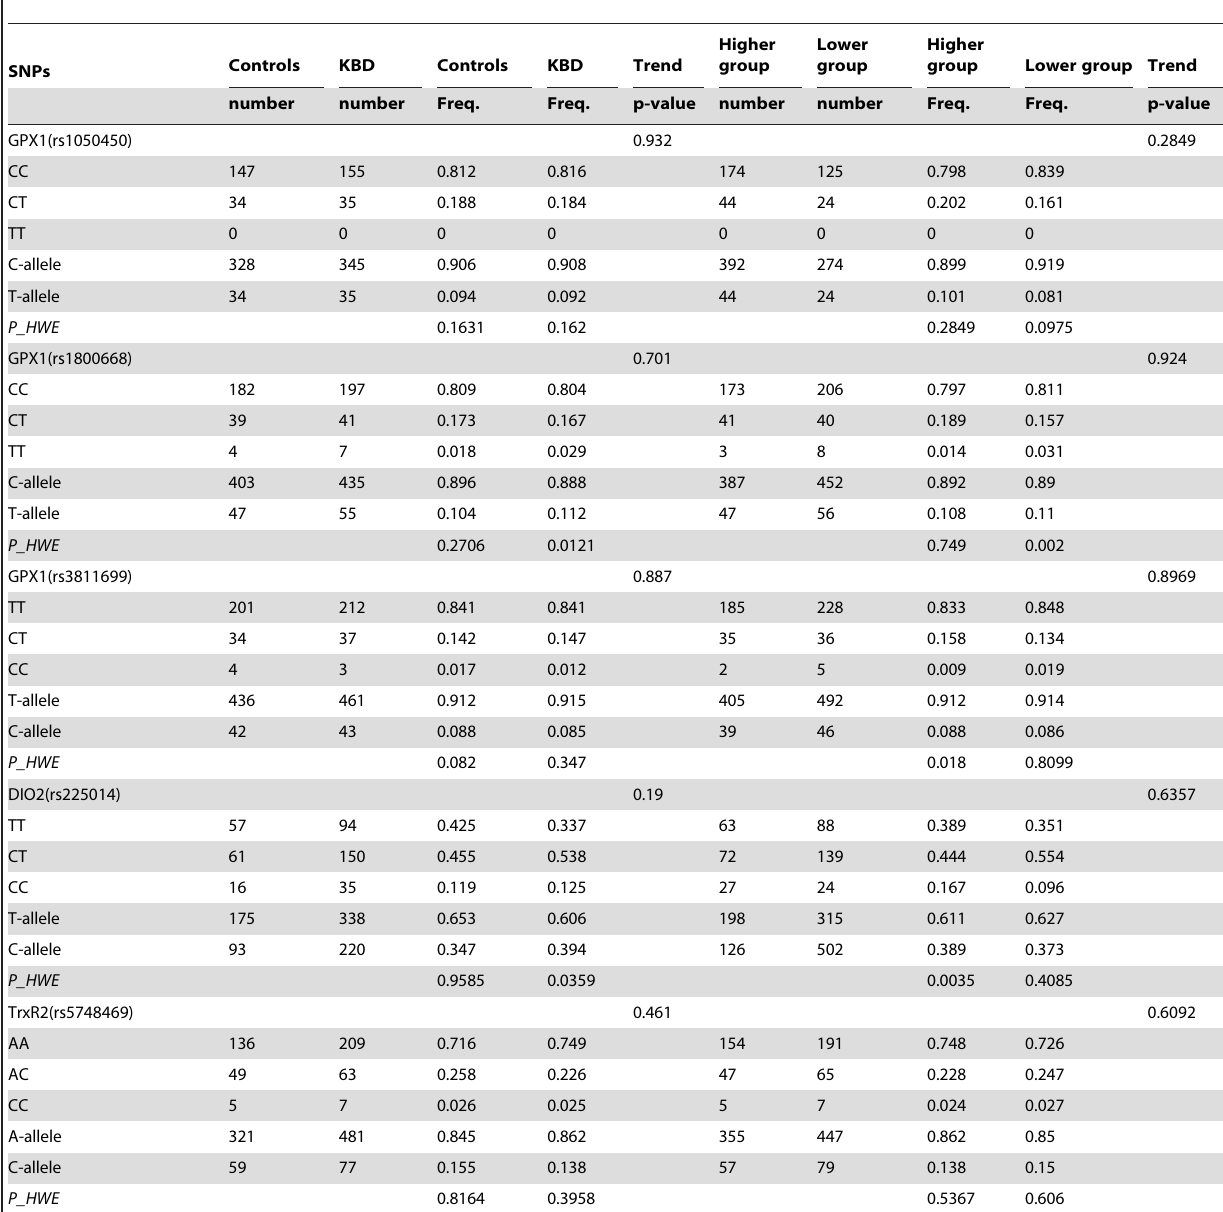
Table 6. Genotype and allele frequencies of polymorphisms across selenoprotein genes by serum selenium concentration in Tibetan population.